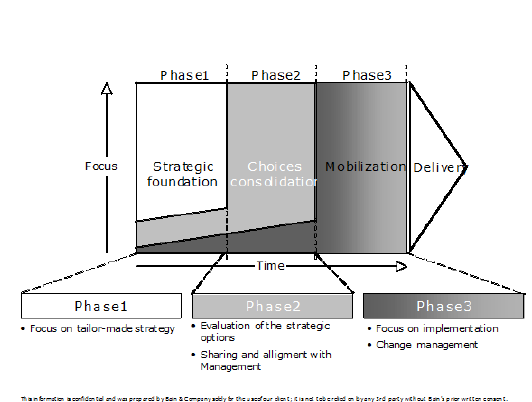
Figure 2: The 3 Phases of the Verify and Implementation’s Process of the